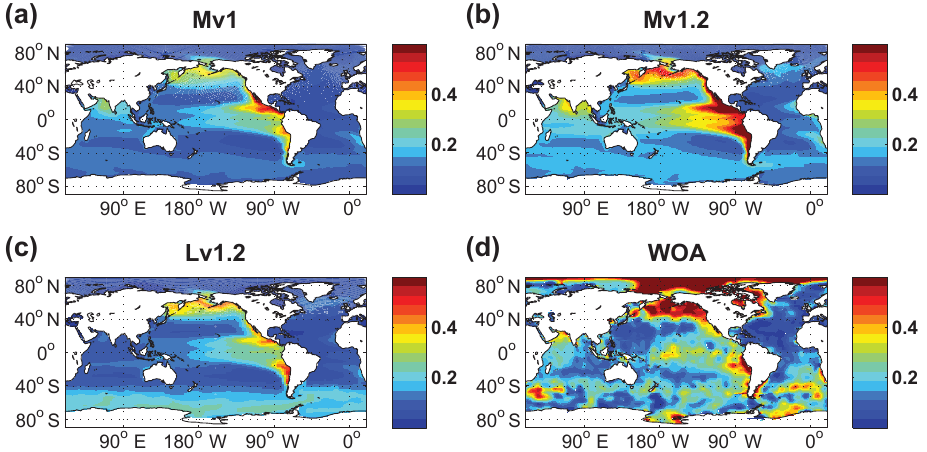
Figure 13. Difference [ PO 4 ]−[ NO 3 ] / 16 (mmolm − 3 ) at the surface averaged over the years 1965 to 2007 for model configurations (a) Mv1, (b) Mv1.2, (c) Lv1.2, and (d) surface [ PO 4 ]−[ NO 3 ] / 16 as calculated from the World Ocean Atlas gridded data